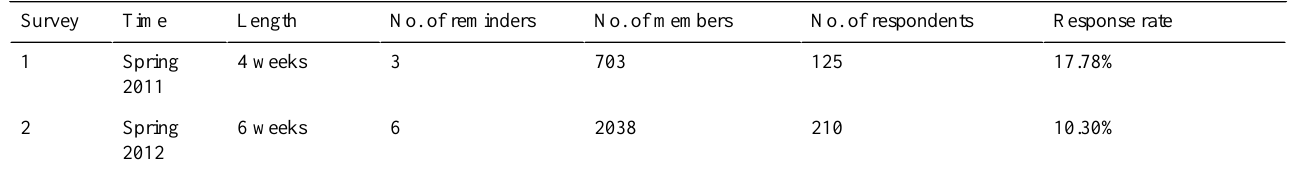
Table 3. Survey data